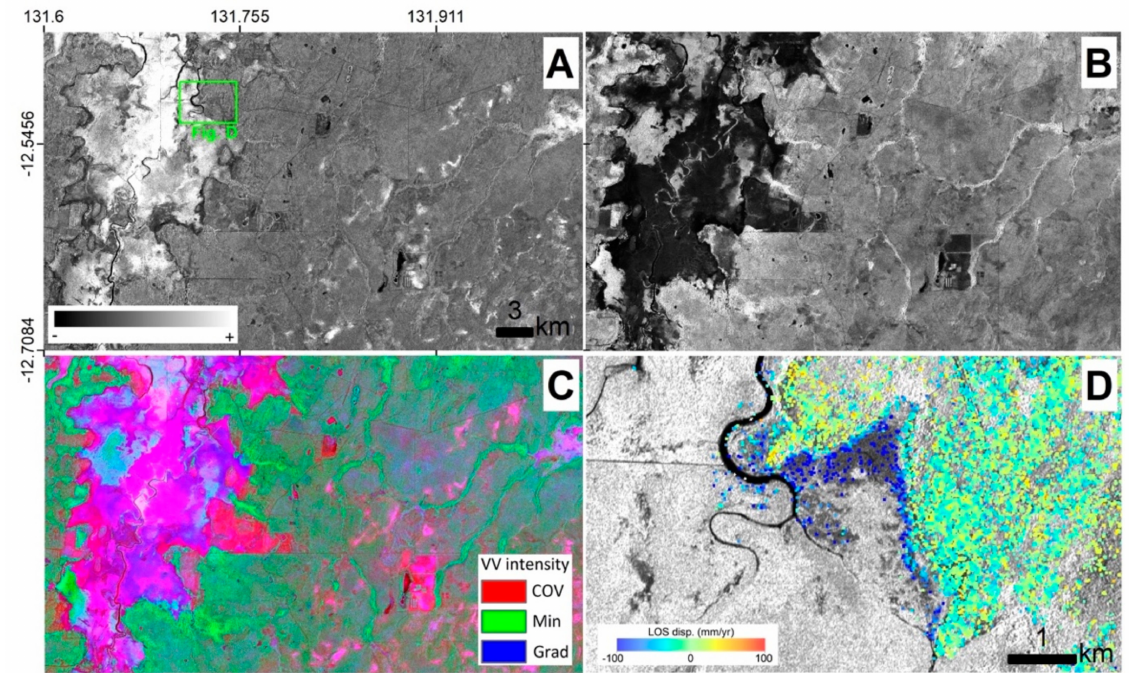
Figure 10. Monitoring geomorphological changes in the Wildman coastal plain, Northern Territory, using Sentinel-1 between 20170108. and 20171222. ( A , B ) Maximum and Minimum pixel-values of VV intensity, respectively, throughout the observation period with the location of D shown by the green box. ( C ) Map of the COV, Minimum, and Maximum Gradient of VV intensity derived from the SAR time-series as in Figure 3. ( D ) InSAR-derived velocities showing negative LoS velocities on the floodplain